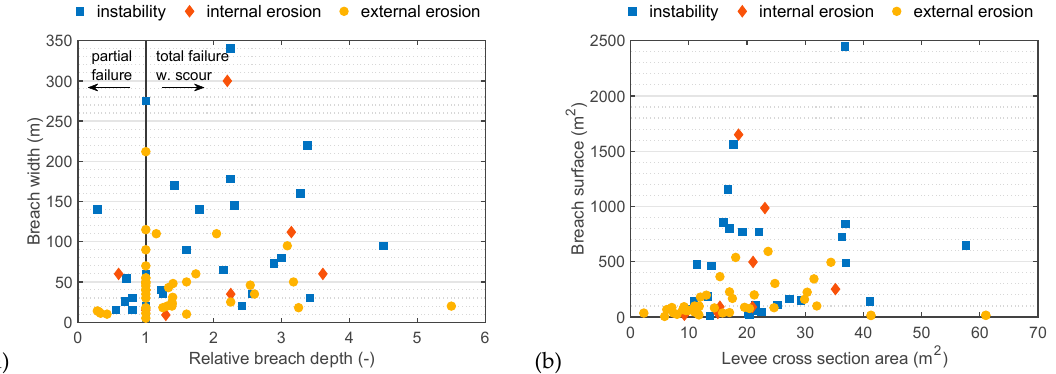
Figure 11. Relation between ( a ) relative breach depth and breach width per failure mechanism; ( b ) breach surface and geometry of the levees per failure mechanism.